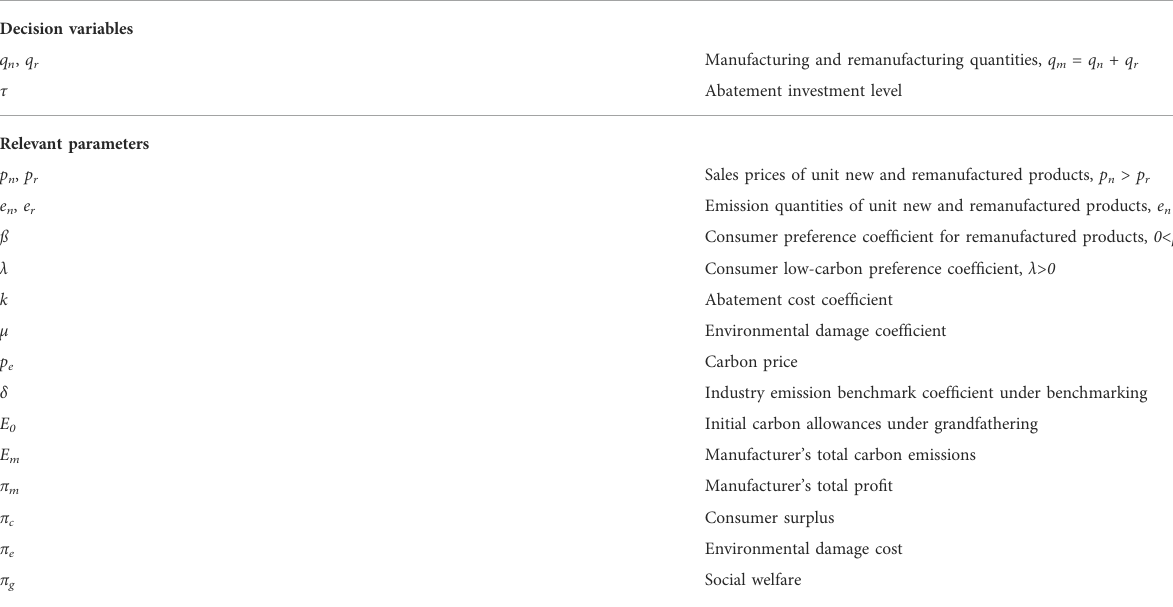
TABLE 1 Decision variables and relevant